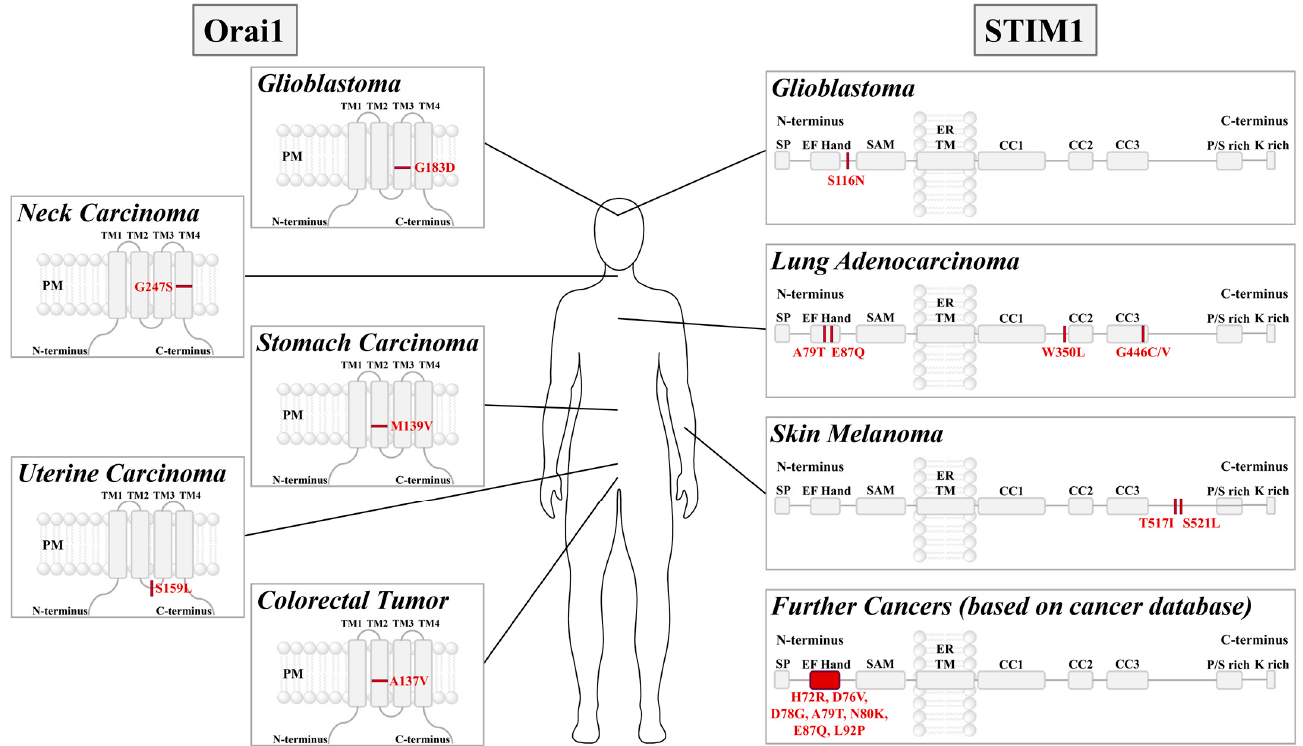
Figure 5. STIM1 and Orai1 cancer-related mutations. Schematic representation of the major components of STIM1 and Orai1 highlighting those point mutations associated with cancer cell development, including glioblastoma, cervical cancer, gastric cancer, uterine cancer, colorectal tumor, glioblastoma, lung adenocarcinoma, skin melanoma, and others [144,290]. Software used for all figure drawings: Procreate, Chemdraw (RRID:SCR_016768).